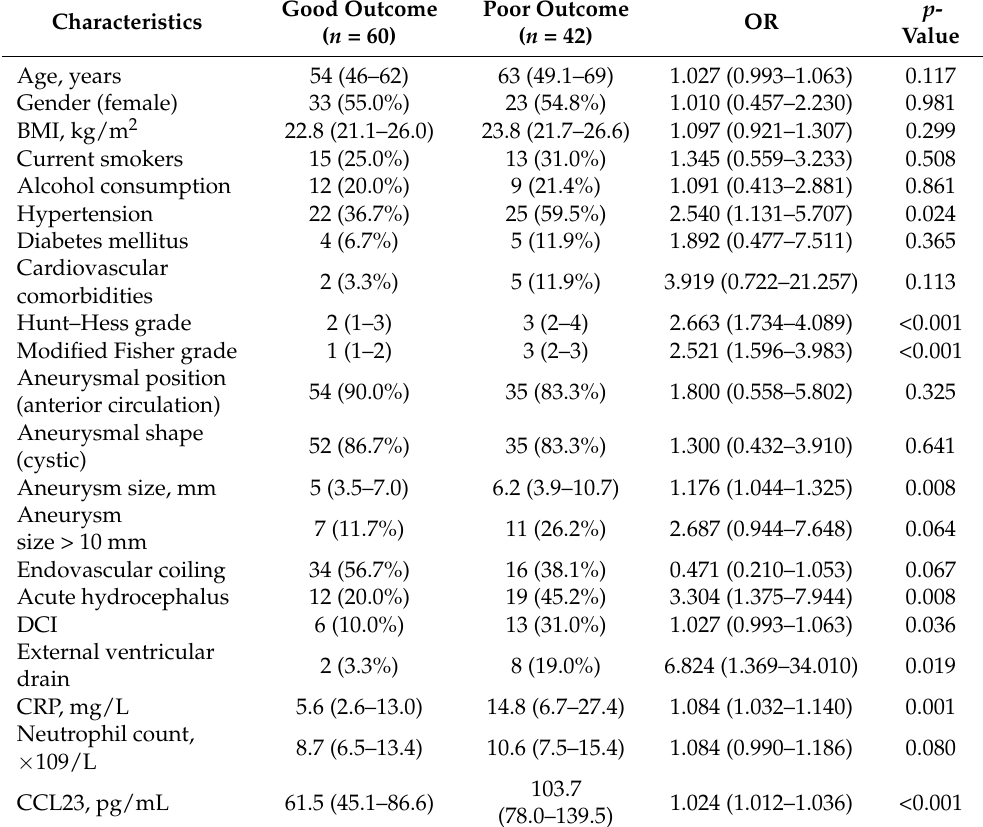
Table 3. Univariate logistic regression analysis of characteristics associated with 6-month poor